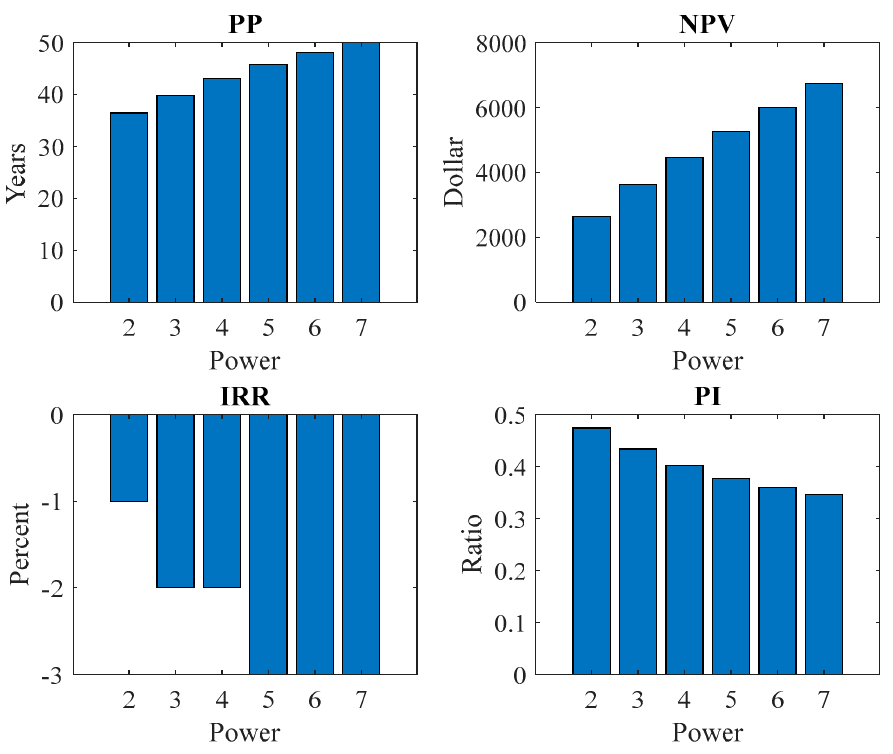
Figure 12. Economic parameters of building 1 in the state B.